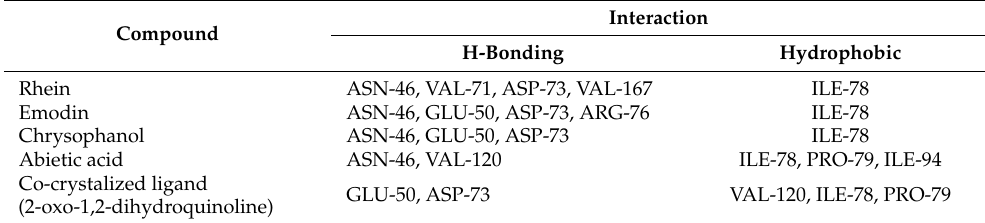
Figure 5. Binding modes of the active top-scoring hits (i.e., rhein, emodin, chrysophanol, physcion, anthrarufin, aloin; brick red-colored structures; ( A – F ), respectively) the co-crystalized ligand, D-cycloserine (orange-colored structure; ( G )) inside the active site of Ddl-B. These binding modes were derived from the MDS experiments (i.e., the last snapshots of the 50 ns trajectories). Table 4. Interactions of the active Gyr-B top-scoring compounds inside the enzyme’s ATPase